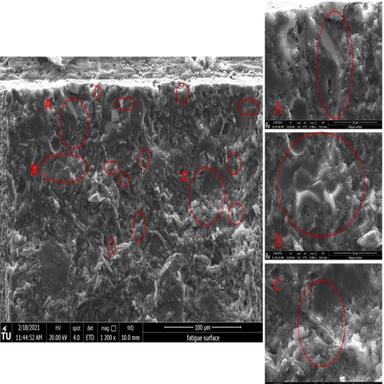
SE images of fatigue fractured surfaces of micro-cantilever beams and marked nanoscale cracks, adapted from.